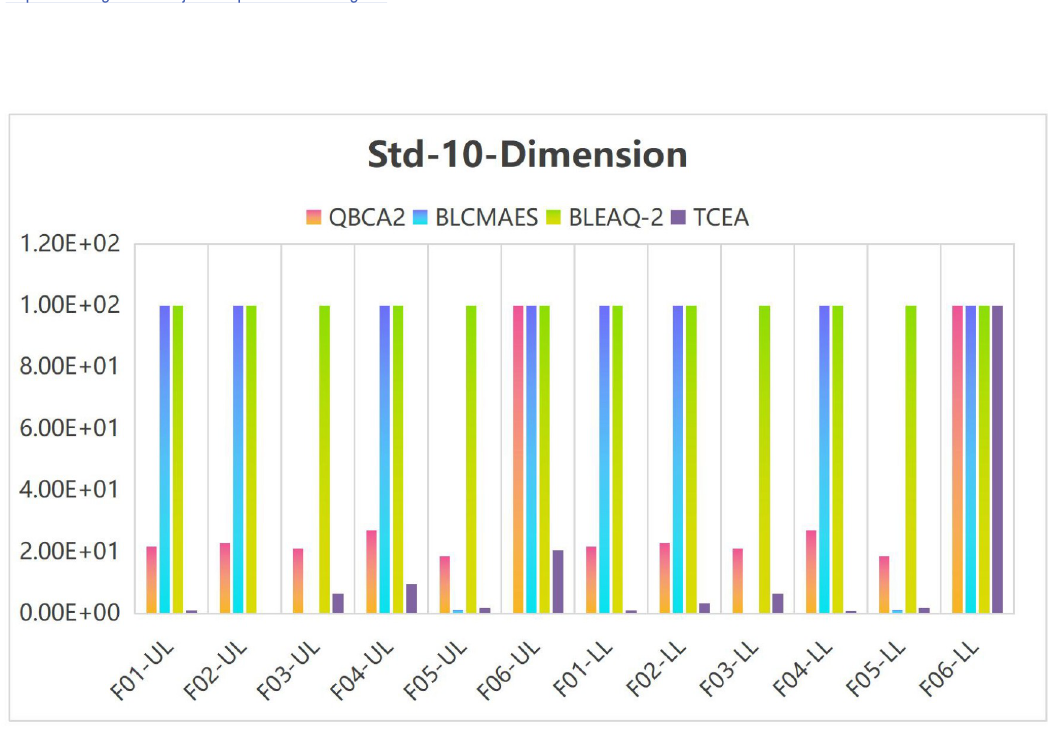
Fig 5. Histogram of the Std values on 10-dimensional problems.